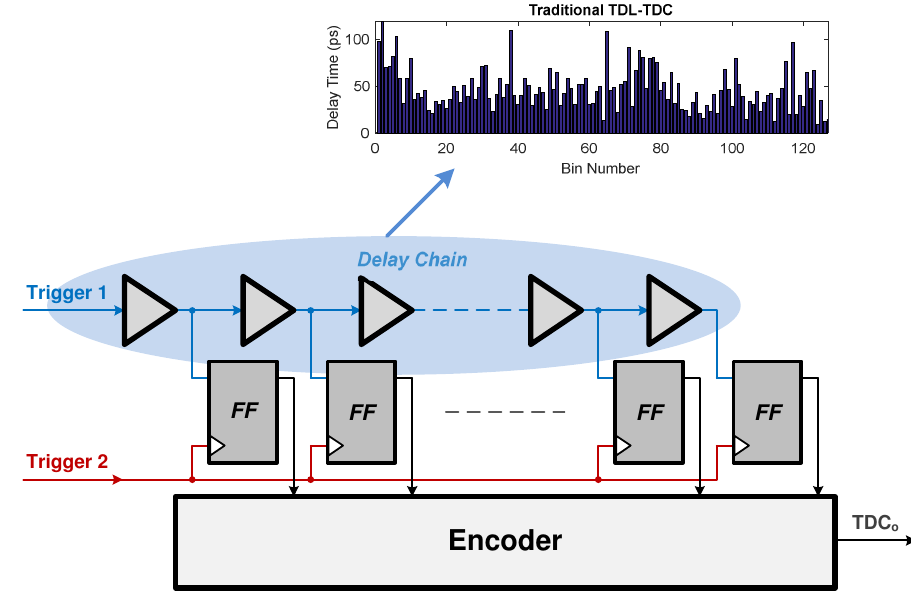
Figure 1. Architecture of